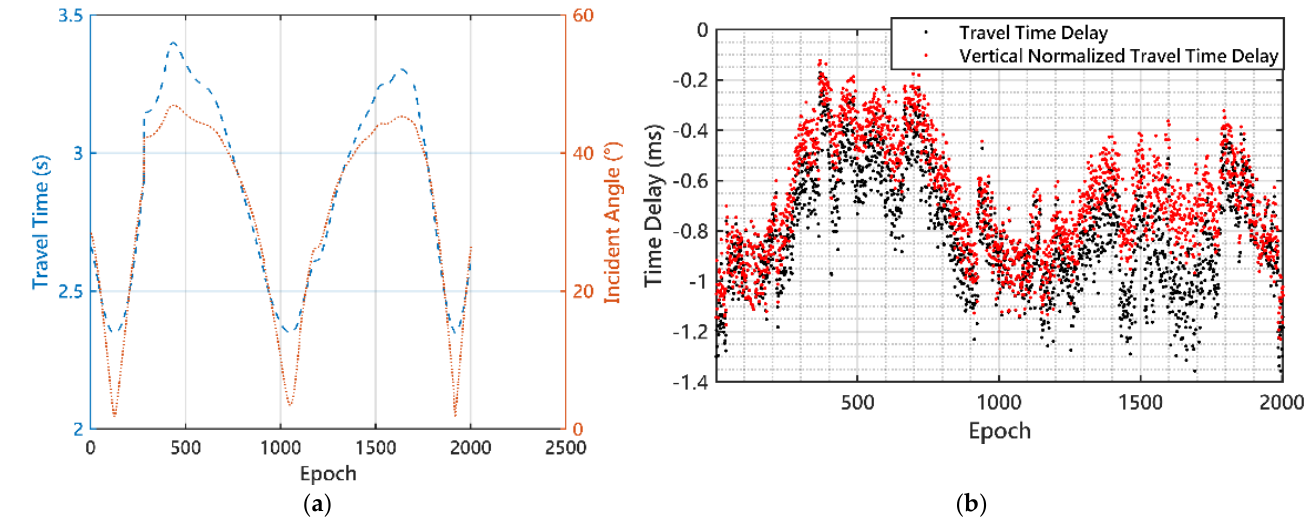
Figure 11. The acoustic round-trip travel time and incident angle of the cross line ( a ). The travel time delay and vertical normalized travel time delay of the cross line ( b ).